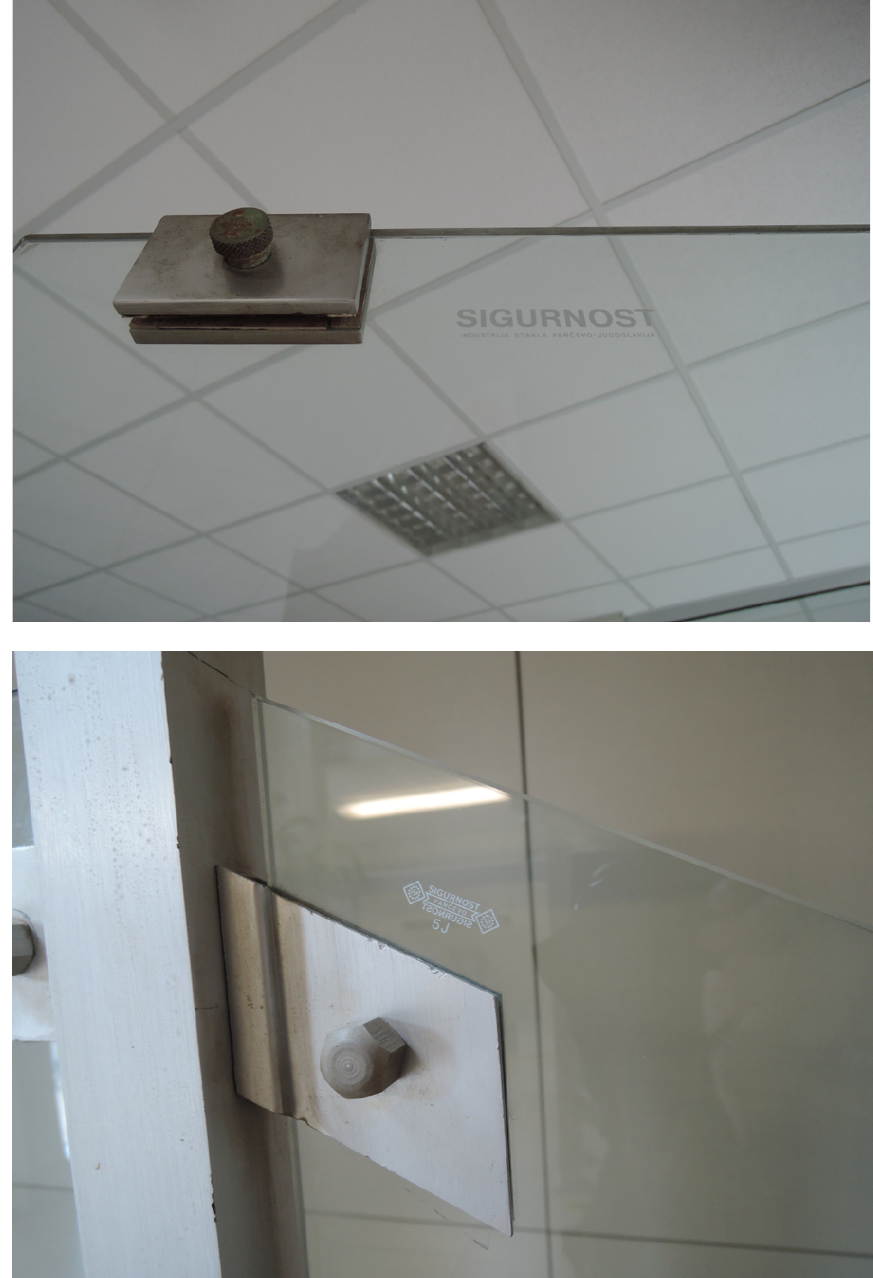
A detail of the interior of the Krym hotel: the original glass door made by Sigurnost, Pančevo, Serbia, kept after restoration (Photo: Jelica Jova- nović,